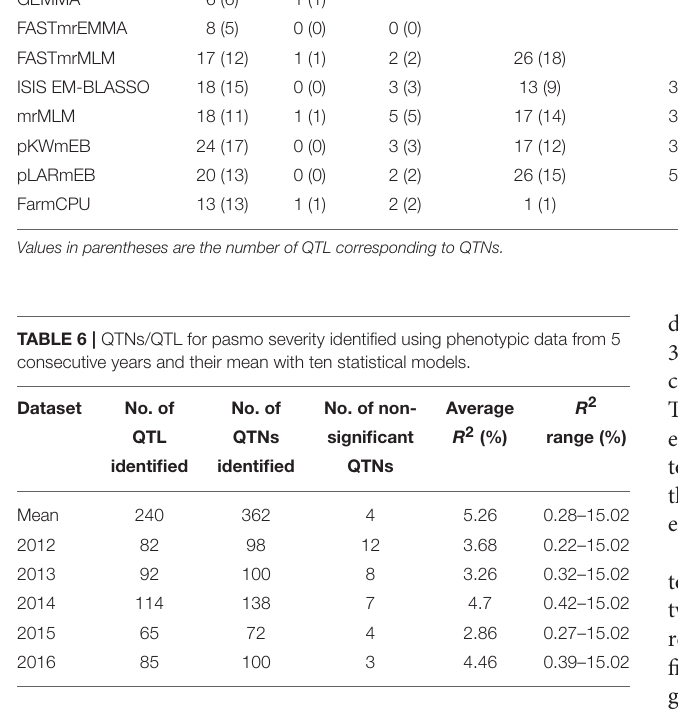
TABLE 7 | Number of common QTNs/QTL identified from any two datasets.